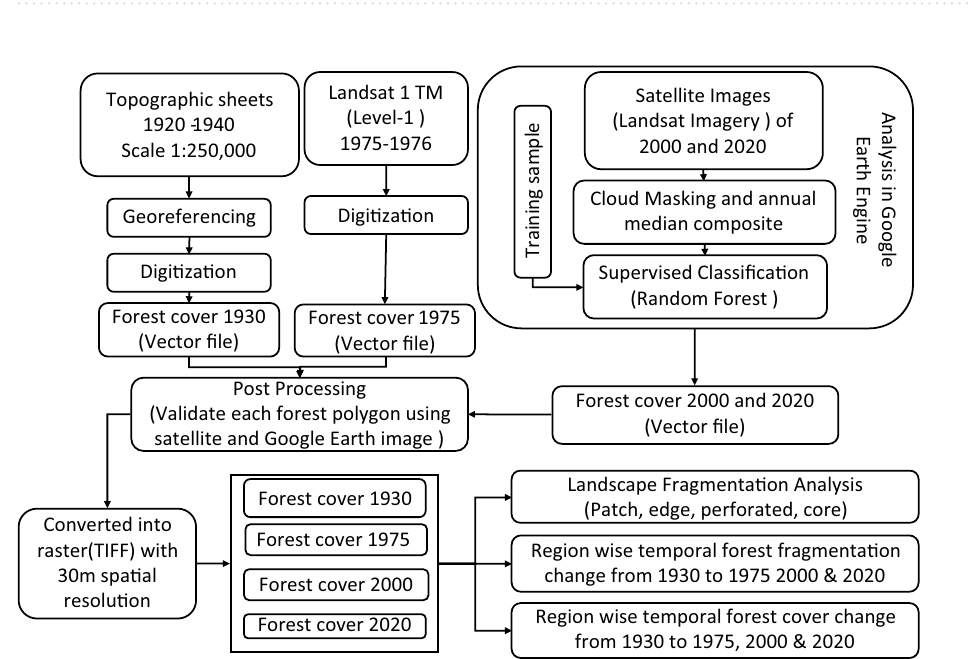
Figure 4. Overall methodological framework adopted for this